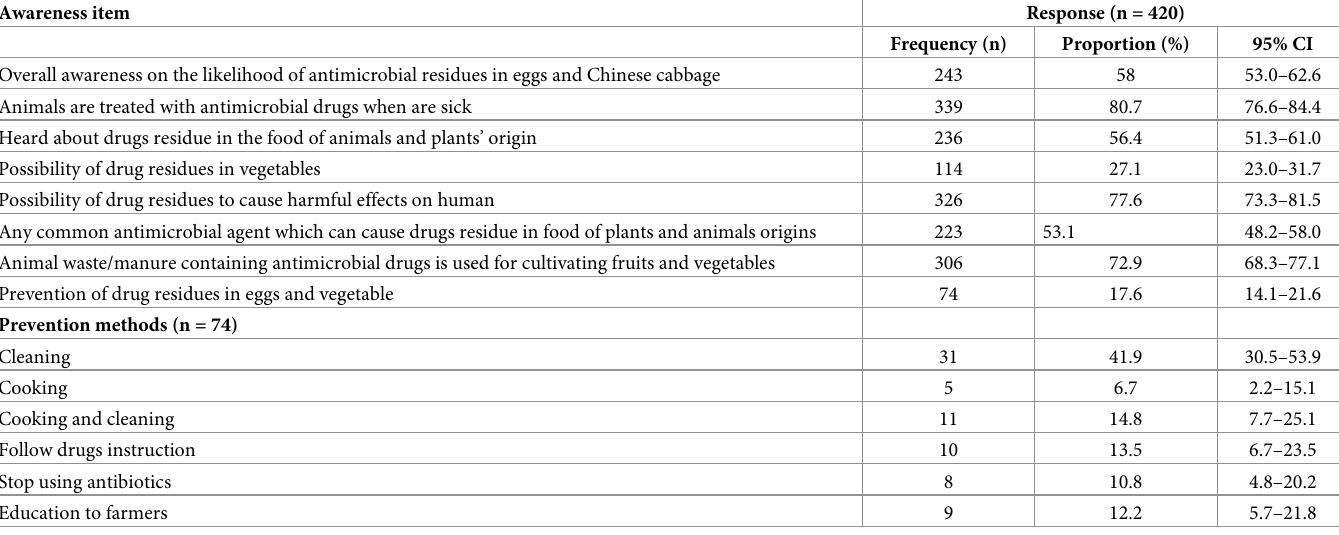
Table 3. Consumer’s awareness of drug usage in animal production and preventive methods of antimicrobial residues in eggs and Chinese cabbage.